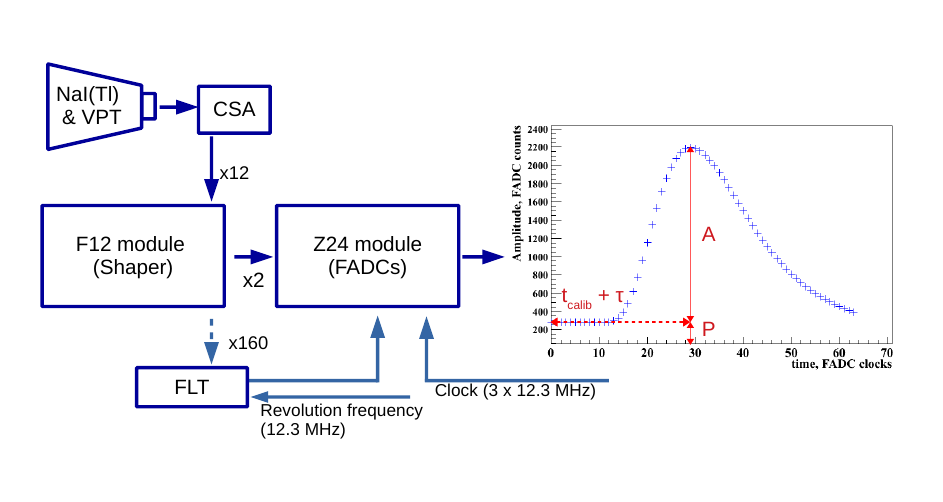
Figure 3. Schematic layout of the EMC spectrometric channel and a typical EMC signal shape. The abbreviations are described in the